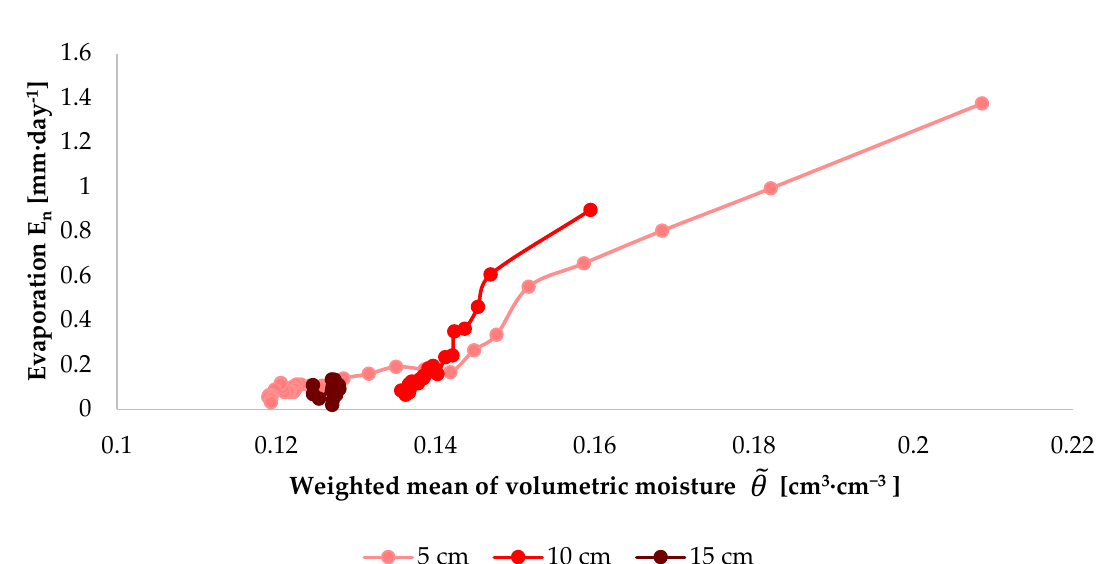
Figure 10. Evaporation versus weighted mean of volumetric moisture after the injection dose of 750 cm 3 at depths of 5, 10, and 15 cm.